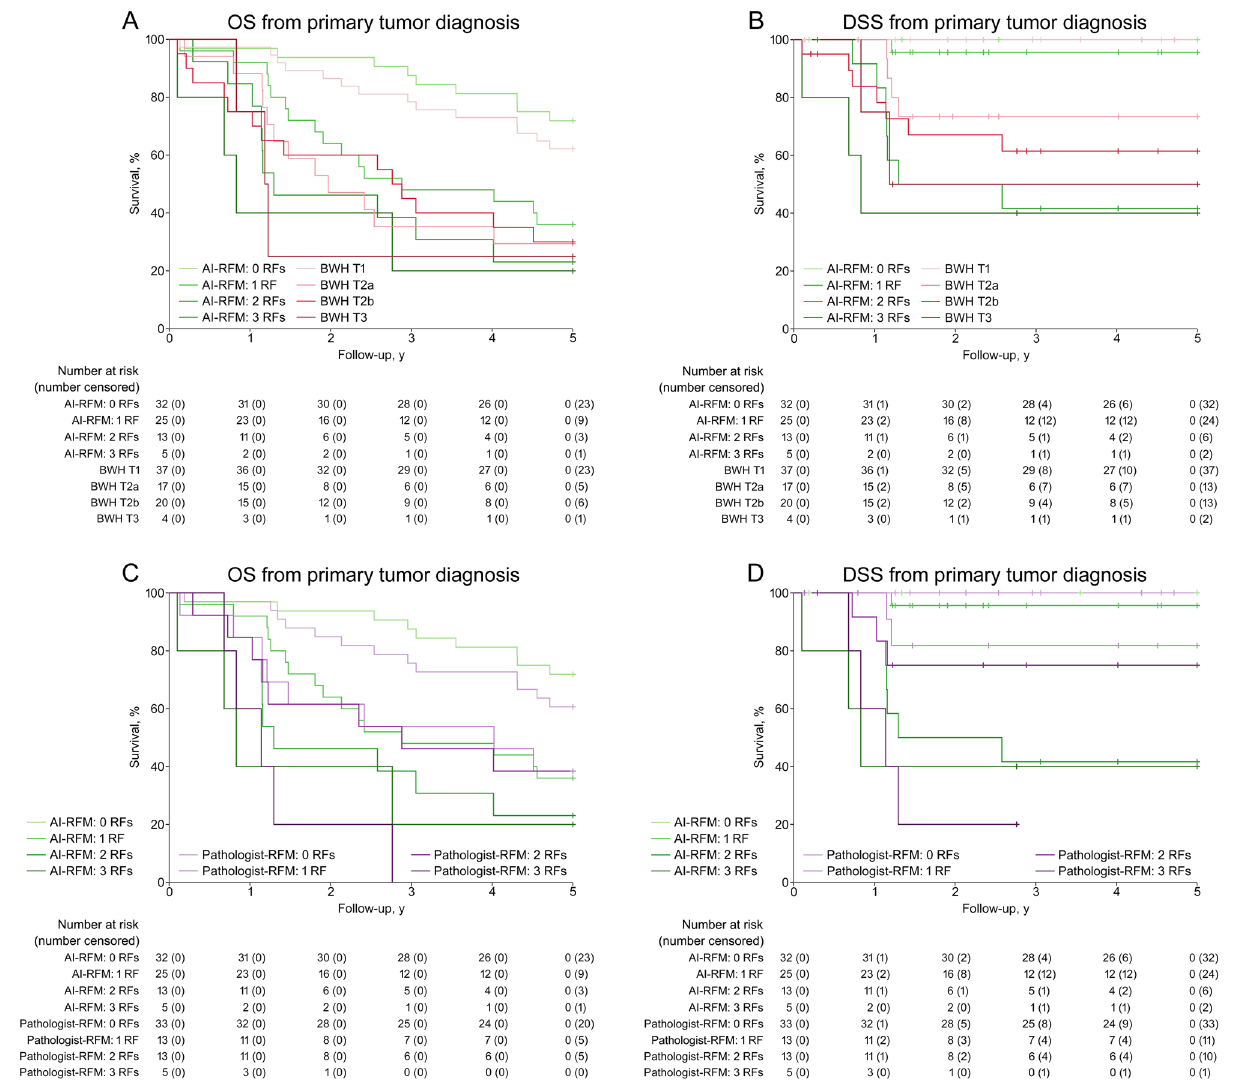
Figure 4. Kaplan–Meier overall survival (OS) and disease-specific survival (DSS) estimates calculated from the initial diagnosis of primary cSCC (rapid metastasis and non-metastatic cohorts, total tumor n = 81). ( A ) OS and ( B ) DSS estimates of cSCCs based on grouping by artificial intelligence- risk factor model (AI-RFM) taking into account prediction by AI as metastatic, tumor diameter ≥ 30 mm and Clark’s level 5 as risk factors and by Brigham and Women’s hospital (BWH) tumor staging. ( C ) OS and ( D ) DSS estimates of cSCCs based on classification by AI-RFM taking into account prediction by AI as metastatic, tumor diameter ≥ 30 mm and Clark’s level 5 as risk factors and by similar model utilizing prediction by pathologist instead of AI (pathologist- the analyses. mcSCCs were further divided into two subcohorts: one with primary mcSCCs, which developed metastasis within 180 days (rapid metastasis cohort) (n = 22) and another with primary mcSCCs that developed metastasis after 180 days from the initial diagnosis of primary tumor (slow metastasis cohort) (n = 23). Clinical, histopathological, follow-up and demographic data were gathered manually from patient records and pathology reports (Tables 1,2). All mcSCCs developed at least one nodal metastasis and part also distant metastases. In survival analyses death was the primary clinical endpoint. The exact cause of death was rarely reported and autopsies were infrequently performed, but the cause of death could be deduced from patient records with acceptable reliability by clinician (JSK). Both unambiguous OS and deduced DSS were utilized in survival analy- ses. Survival time was calculated from the date of initial diagnosis of the primary cSCC with 5 years of follow-up. Death represented the end of follow-up. Tissue specimens (slides) were scanned with 3DHistech scanner (3DHistech, Budapest, Hungary) and anno- tated using CaseViewer (3DHistech, Budapest, Hungary). The WSIs representing cSCCs were manually anno- tated. Annotated area included whole tumor represented on the WSI, including tumor cells, intratumoral and peritumoral stroma, as well as intratumoral inflammatory cells (Supplementary Fig. 3). Additionally, manual